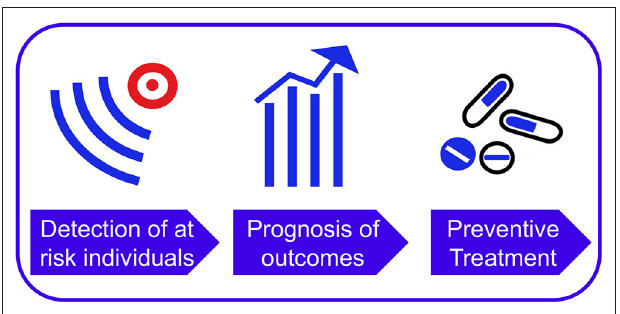
FIGURE 1 | Core clinical and research components for effective prevention of